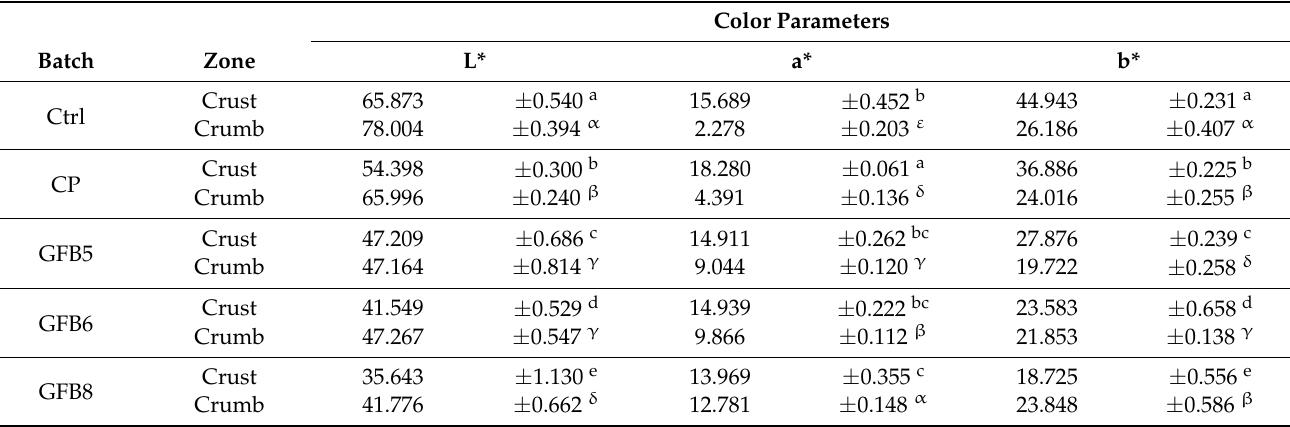
Table 6. Mean values ± standard error of CIELAB coordinates (L*, a*, b*) in crust and crumb for each bread